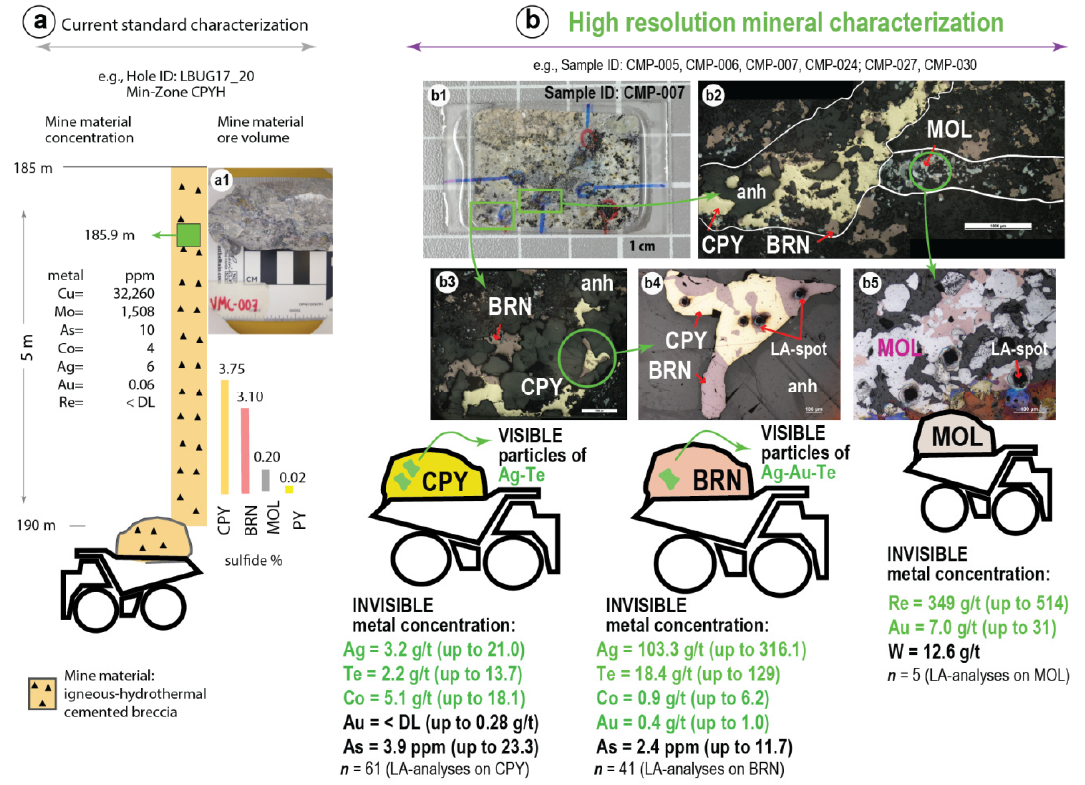
Figure 5. Schematic diagram illustrating: ( a ) current Cu-sulfide geochemical characterization, consisting of bulk geochemical analyses performed on 5 m-composite samples of mine material (on the right side a photograph is shown, a1). ( b ) The proposed high-resolution characterization for the GMU1, showing the mode of occurrence for each metal-bearing sulfide and the specific metal content, including the grade and mode of occurrence for metals.